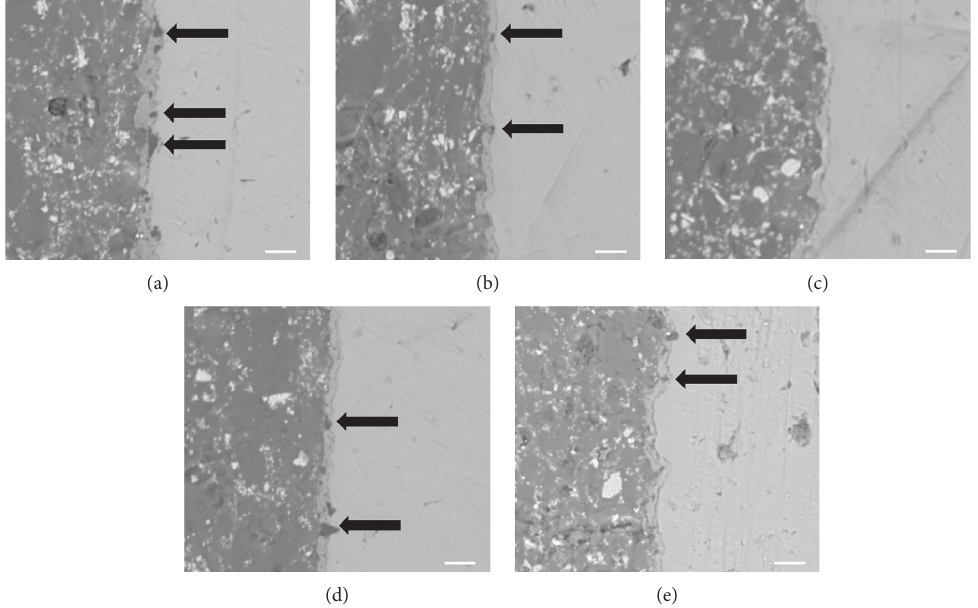
Figure 3: SEM microphotographs of titanium-porcelain interface: (a) control group, (b) 10g/L MgSiF 30g/L MgSiF 6 group, and (e) 40g/L MgSiF 6 group. Bar � 10 μ m. The pores and cracks are indicated by